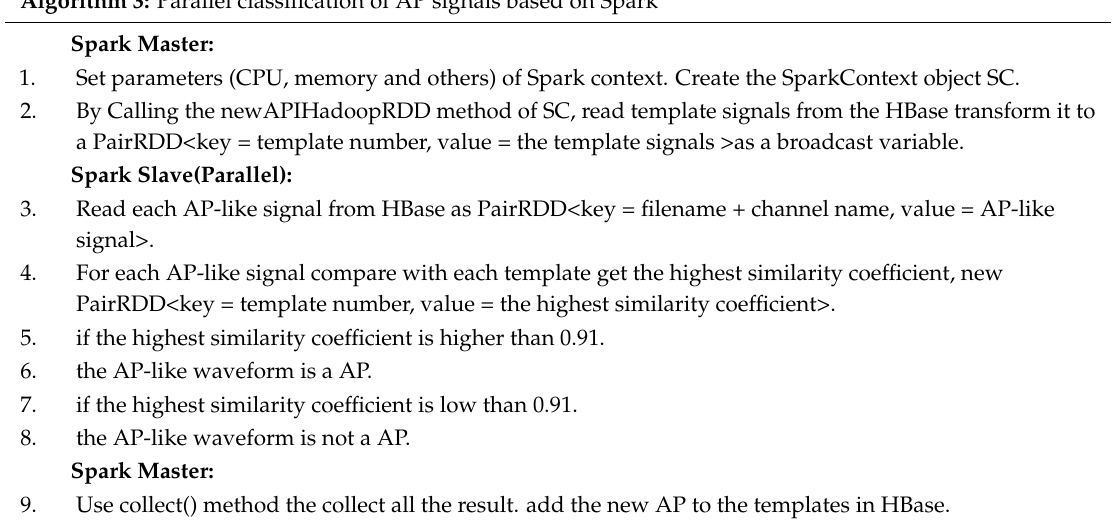
Algorithm 3: Parallel classification of AP signals based on